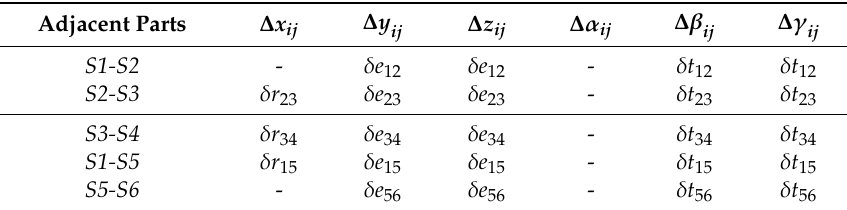
Table 1. Transfer errors of the adjacent